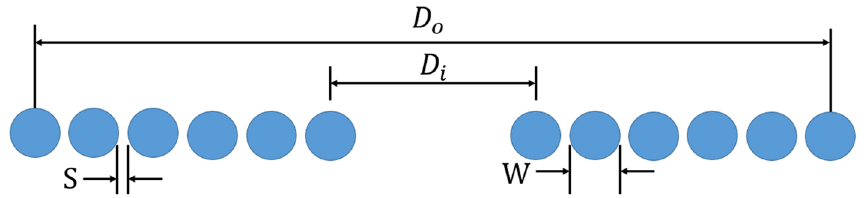
Figure 1. Physical dimensions of the Harold–Wheeler